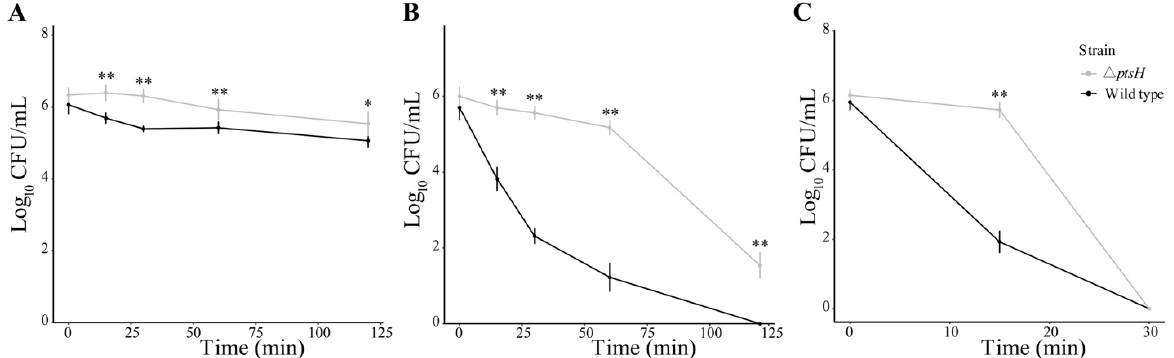
Figure 5. The viability of the WT strain and Δ ptsH mutant under 1 mM H 2 O 2 ( A ), 5 mM H 2 O 2 ( B ), and 10 mM H 2 O 2 ( C ). ** p < 0.01, * p < 0.05 compared to the WT strain.